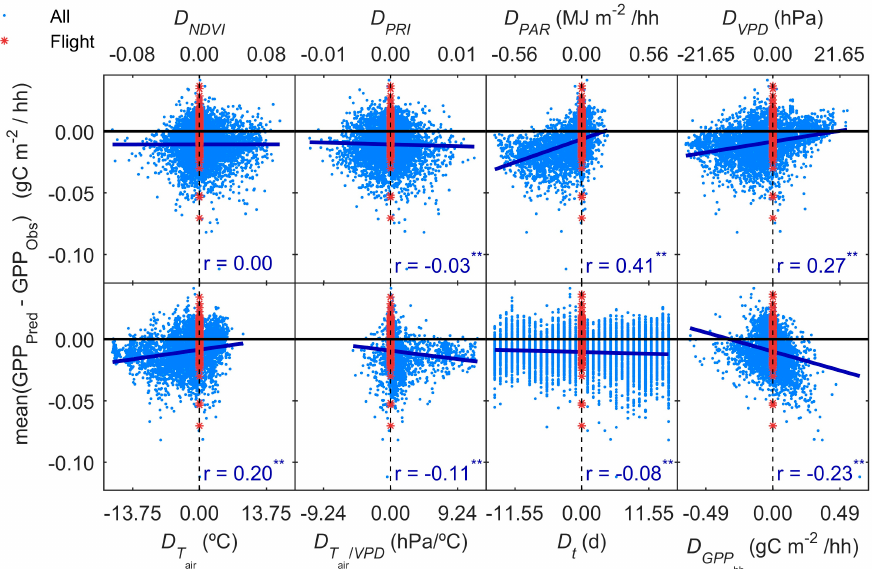
Figure 8. Mean error of MOD2–MOD4 vs. the difference of different variables respect to their values each half-hour the days of the flight campaigns. The adjusted linear model and Pearson correlation coefficient of the whole dataset are shown with the respective significance degree (** p < 0.05; * p < 0.10). In addition, data corresponding of the date of each flight are flagged.